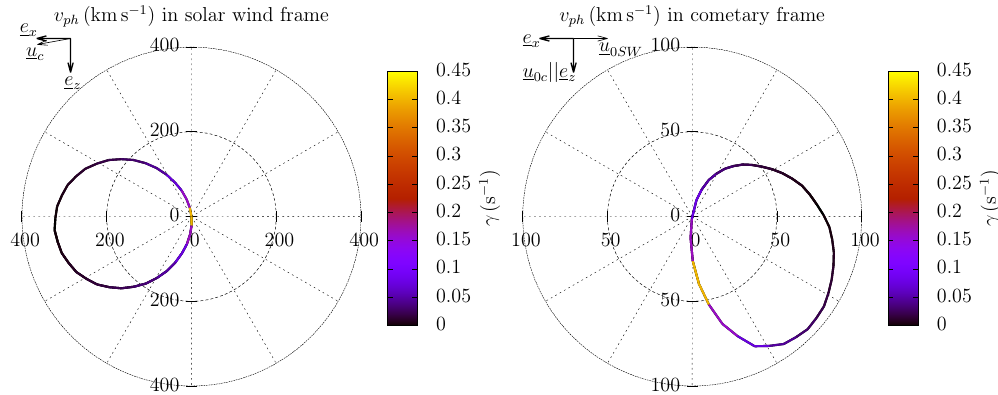
Figure 6. Wave phase velocity diagram v ph = ω c ( k max )/ | k max | in SW (left) and in CSEQ (right). The velocities with colour-coded maximum growth rates γ c ( k max ) are shown in the xz -plane corresponding to Fig. 5 (right). Additionally, the directions of characteristic velocities are indicated.